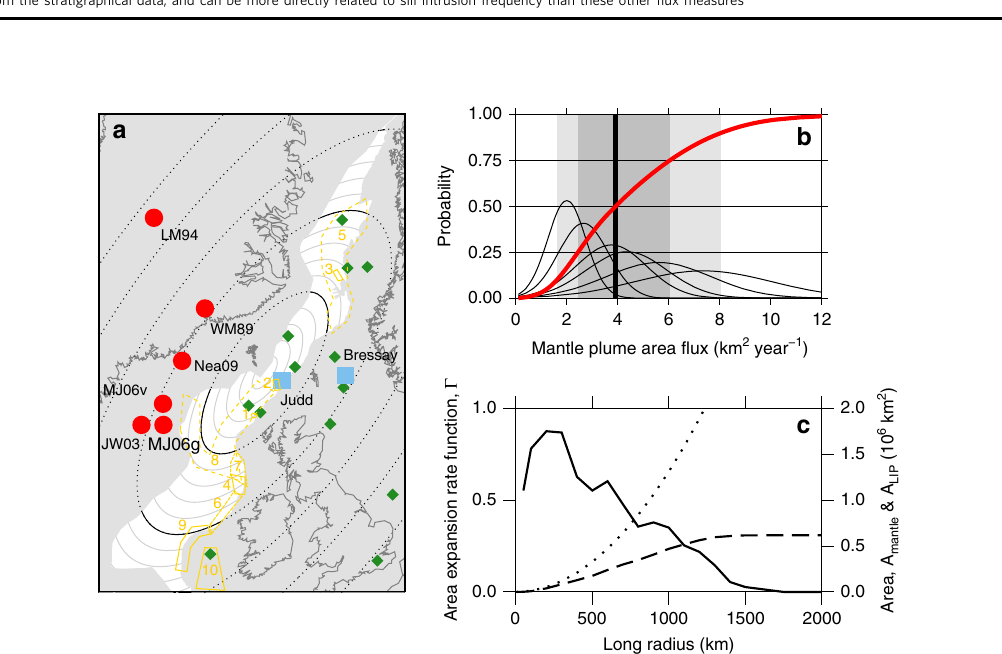
Fig. 6 NAIP geography and plume fl ux data. a Data locations. Blue squares show locations of stratigraphic successions and river pro fi les used to constrain plume fl ux 36 – 38,43 . Red circles show plume centre locations (references in Table 1). Yellow polygons show seismic datasets used to measure sill area density, ρ (key to numbers in Table 2). Ellipses mark edge of the model plume head used for Figs. 7 and 8 at long radii R in increments of 100 km. Green diamonds show locations of dynamic support measurements from stratigraphic sections used to constrain plume head model 18,21,44 . b Mantle plume area fl ux data. Thin black lines show probability density functions associated with the plume fl ux estimates in Table 1, assuming normal distributions with the standard deviations set to one-quarter of the uncertainty ranges. Red line: corresponding cumulative probability function. Thick black line marks median area fl ux; darker grey box shows inter-quartile range of area fl ux; lighter grey box shows 10 – 90% con fi dence interval for plume area fl ux. c Measurement of NAIP sill province area expansion. A mantle (dotted) is the total area inside an ellipse in a . A LIP (dashed) is the area of the NAIP sill province (coloured white) within the ellipse. Γ (solid) is the areal expansion rate